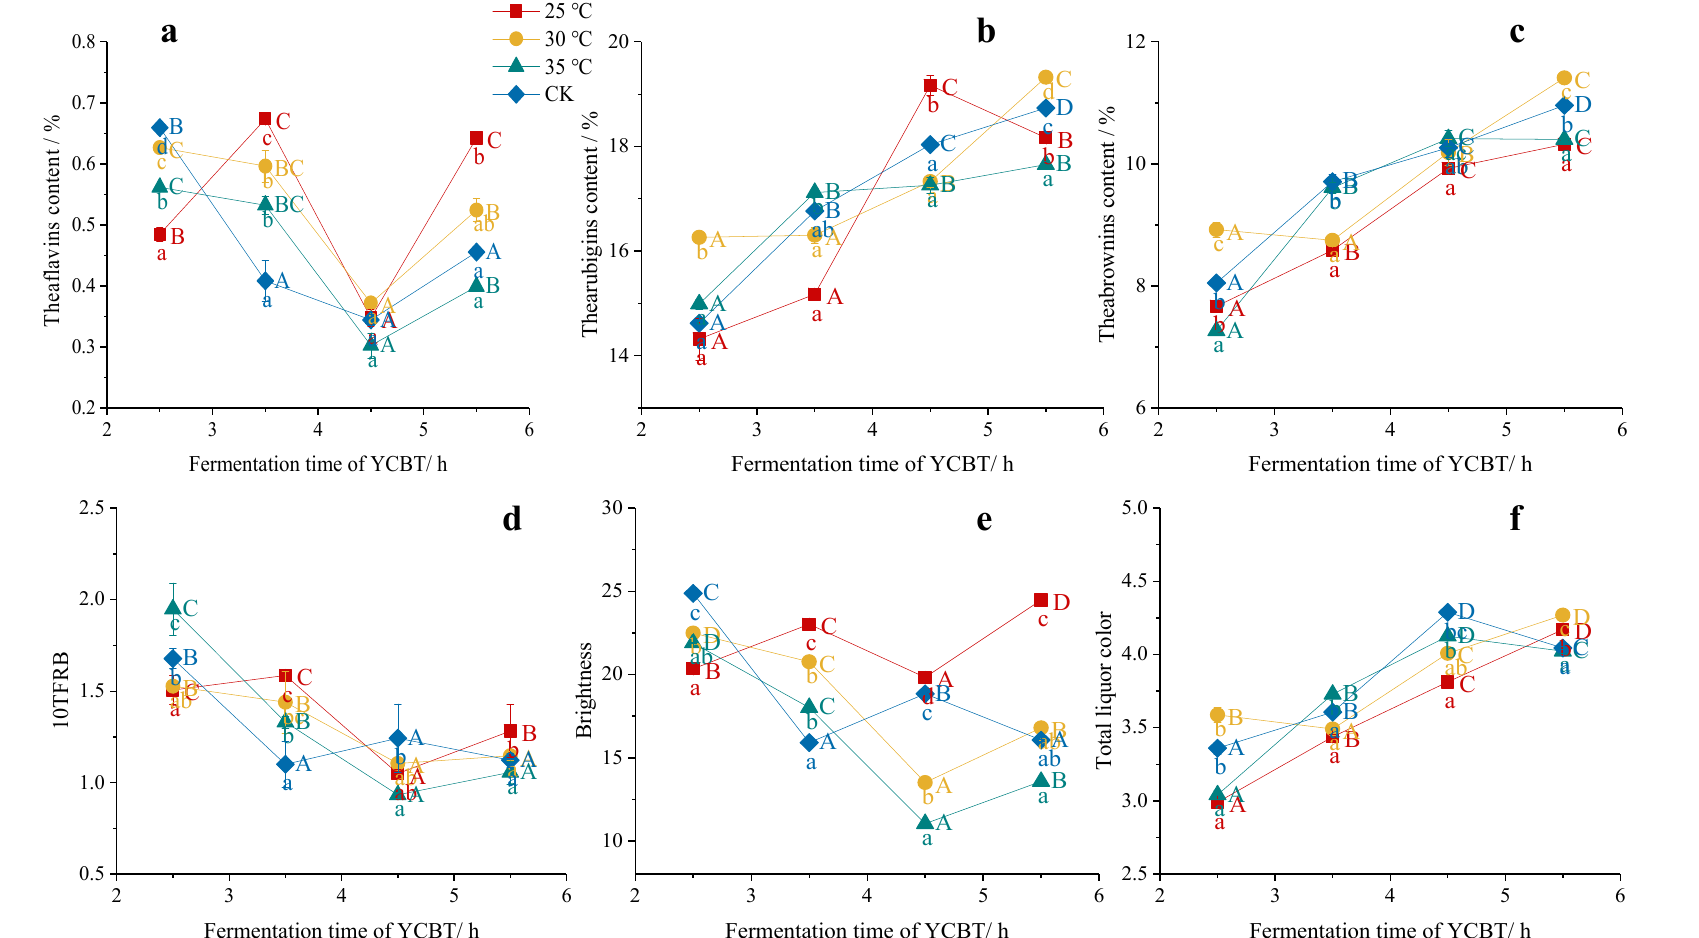
Figure 4. Effect of the fermentation temperature and time on the tea pigment contents of Yunnan Congou black tea (YCBT) fermentation: ( a ) TFs content, ( b ) TRs content, ( c ) TBs content, ( d ) 10TFRB value, ( e ) BT value, and ( f ) TLC value. Note: Mean values with different lowercase letters indicate significant differences between different fermentation temperatures at the same fermentation time ( p < 0.05); Mean values with different capital letters indicate significant differences between different fermentation times at the same fermentation temperature ( p <